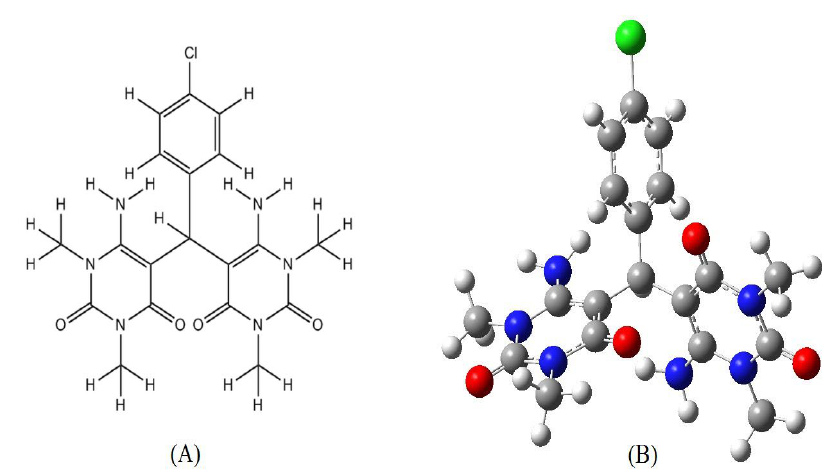
Figure 2. The molecular structure ( A ) and the optimized structure ( B ) of the proposed compound.